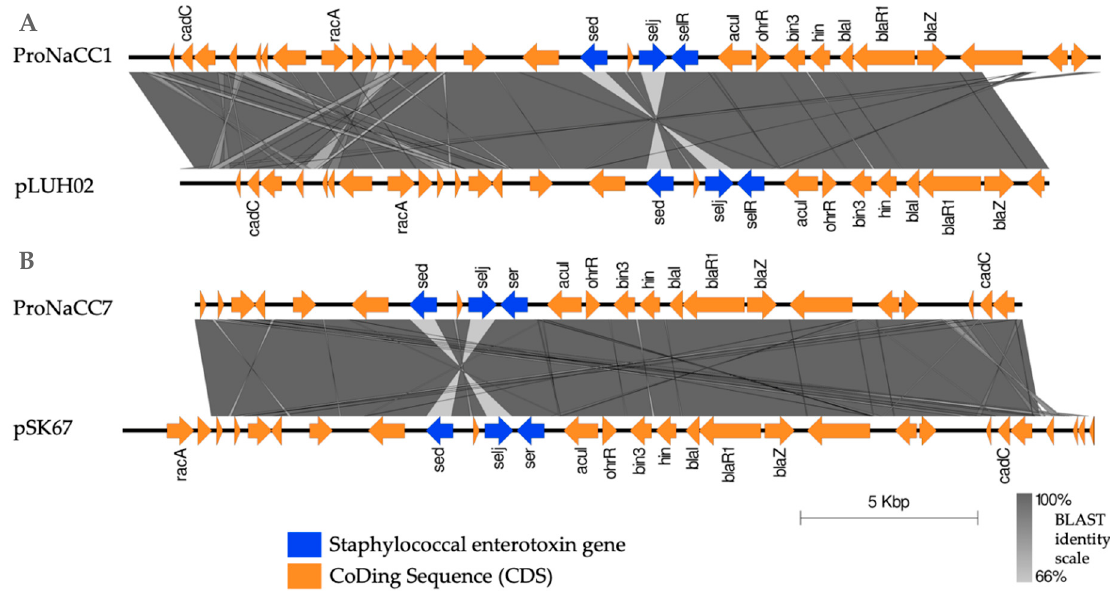
Figure 8. Comparison of plasmidic regions detected in the genome of the strains ProNaCC1 ( A ) and ProNaCC7 ( B ) with the plasmids pLUH02 and pSK67. The regions included the enterotoxin and enterotoxin-like genes and the coding sequences (CDS) detected in the regions.